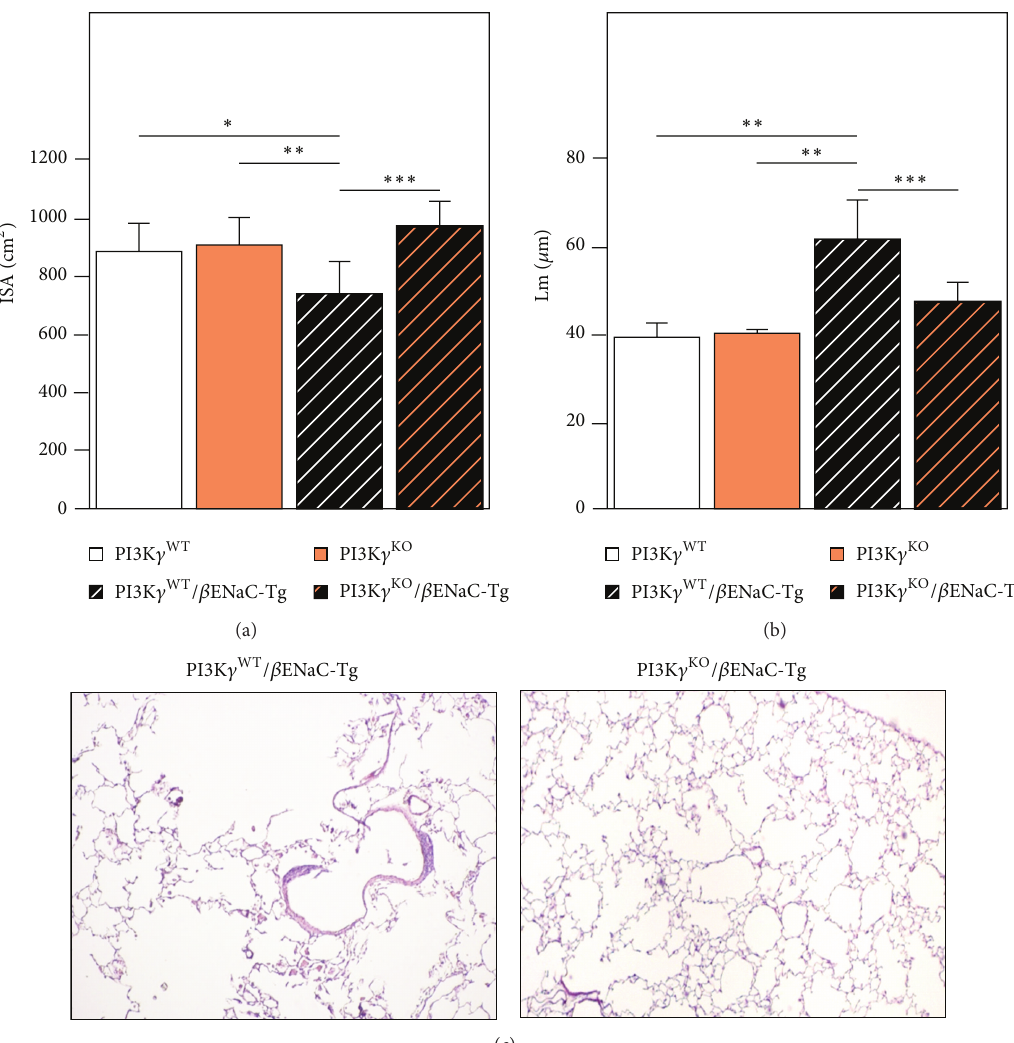
Figure 2: Genetic deletion of PI3K 𝛾 decreases emphysema in 𝛽 ENaC-Tg mice . Mouselungs were fixed in 4% formalin and embedded in paraffin and 5 𝜇 m sections were stained with hematoxylin/eosin; assessment of emphysema included the internal surface area (ISA) at postfixation lung volume and the morphometric assessment of the average inter-alveolar distance (mean linear intercept: Lm). (a) ISA and (b) Lm from 8-week-old wild type (PI 3 K 𝛾 WT ), 𝛽 ENaC-Tg, PI 3 K 𝛾 KO , and PI 3 K 𝛾 KO / 𝛽 ENaC-Tg mice ( 𝑛 = 8–10 mice for each group). Comparison among groups was performed using one-way analysis of variance. (a) ∗ 𝑃 < 0.05 PI 3 K 𝛾 WT versus PI 3 K 𝛾 WT / 𝛽 ENaC-Tg, ∗∗ 𝑃 < 0.01 PI 3 K 𝛾 KO versus PI 3 K 𝛾 WT / 𝛽 ENaC-Tg, ∗∗∗ 𝑃 < 0.001 PI 3 K 𝛾 WT / 𝛽 ENaC-Tg versus PI 3 K 𝛾 KO / 𝛽 ENaC-Tg; (b) ∗∗ 𝑃 < 0.01 PI 3 K 𝛾 WT versus PI 3 K 𝛾 WT / 𝛽 ENaC-Tg, and 𝑃 < 0.01 PI 3 K 𝛾 KO versus PI 3 K 𝛾 WT / 𝛽 ENaC-Tg, ∗∗∗ 𝑃 < 0.001 PI 3 K 𝛾 WT / 𝛽 ENaC-Tg versus PI 3 K 𝛾 KO / 𝛽 ENaC-Tg mice. (c) Representative histological sections from the lung of 8-week-old 𝛽 ENaC-Tg mousee (left) showing evident areas of emphysema and PI 3 K 𝛾 KO / 𝛽 ENaC-Tg (right) mouse showing a focal areas of mild emphysema. Haematoxylin and eosin stain. Original magnification ×